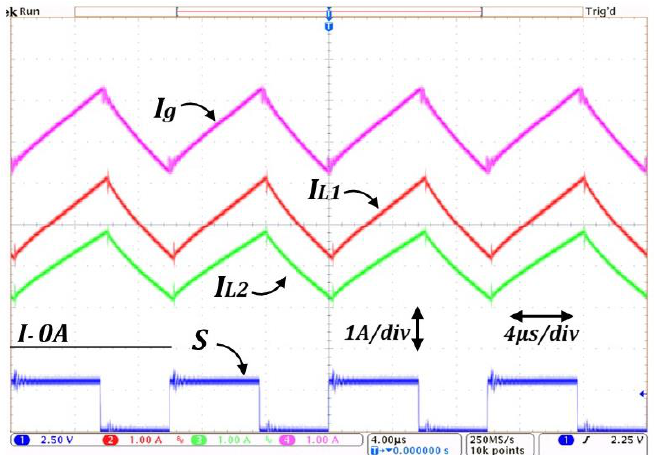
Figure 22. From button to top: the switching function of the transistor s, current through inductors, and input current when V g = 85 V , V o = 200 V , P o = 400 W .